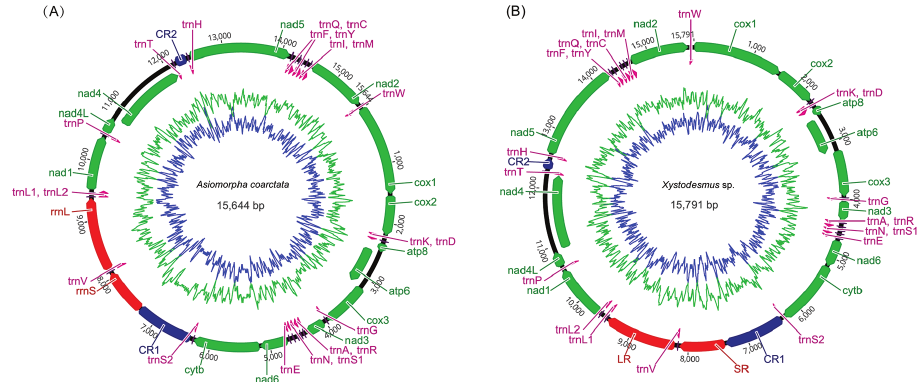
Figure 1. Mitochondrial genomes of the two millipedes sequenced in this study. A Asiomorpha coarctata B Xystodesmus sp. Circular maps were drawn with Geneious v9.1.2. Arrows indicate the orientation of gene transcription. Abbreviations of gene names are: atp6 and atp8 for ATP synthase subunits 6 and 8; cox1 – 3 for cytochrome oxidase subunits 1–3; cob for cytochrome b, nad1 – 6 and nad4L for NADH dehy- drogenase subunits 1–6 and 4L; and lrRNA and srRNA for large and small rRNA subunits. tRNA genes are indicated with their one-letter corresponding amino acids. CR for control region. The GC content was plotted using a green sliding window and the AT content was